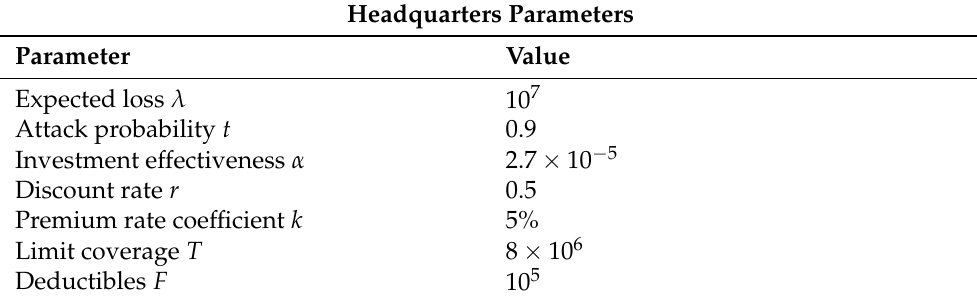
Table 2. Parameters adopted for the headquarters.